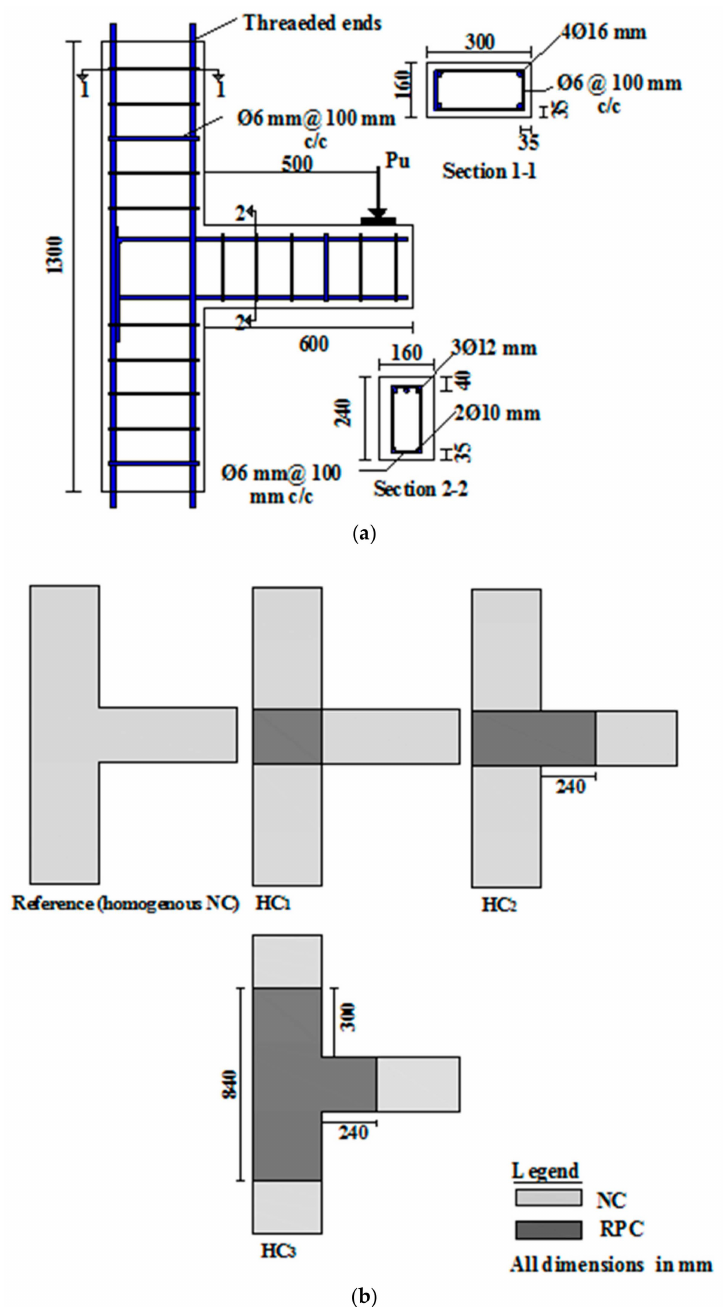
Figure 2. Details of specimens in Group(I) and Group(III) (BCJs with hybrid concrete). ( a ) Details of reinforcement for specimens with hybrid concrete; ( b ) details of hybrid concrete